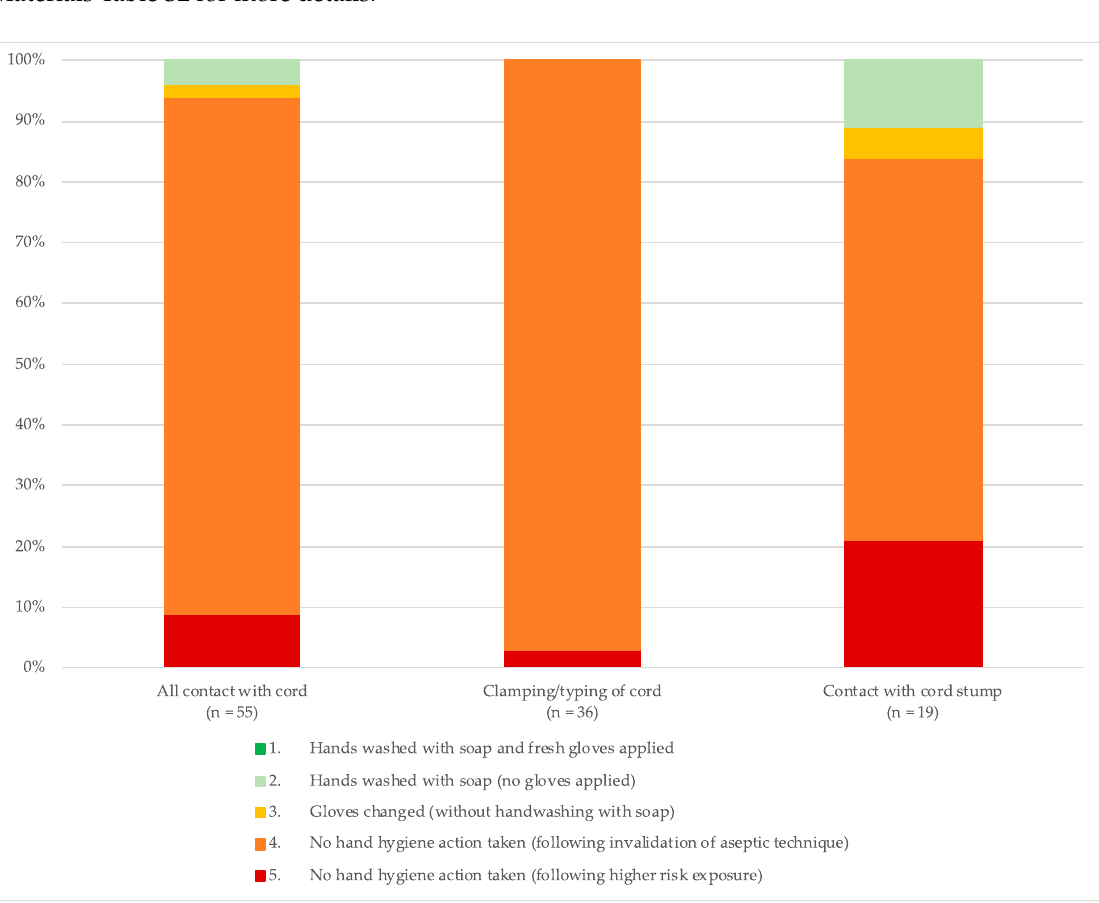
Figure 3. Hand hygiene during neonate-specific procedures requiring aseptic technique during labour and delivery.